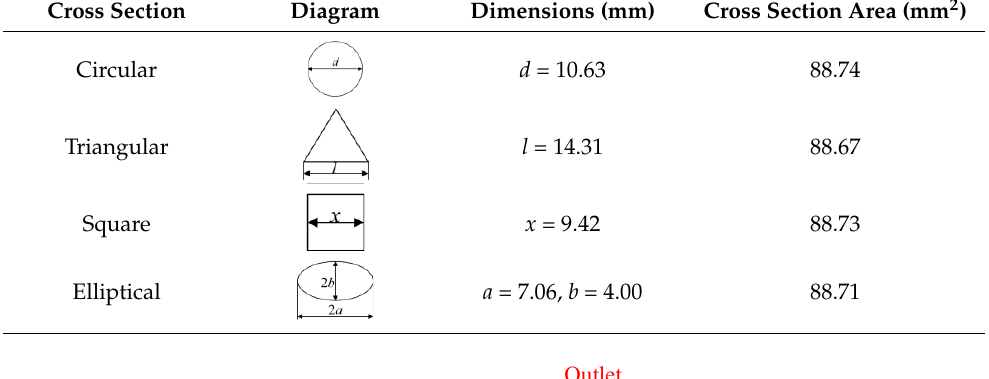
Table 4. Size parameters of different shapes.